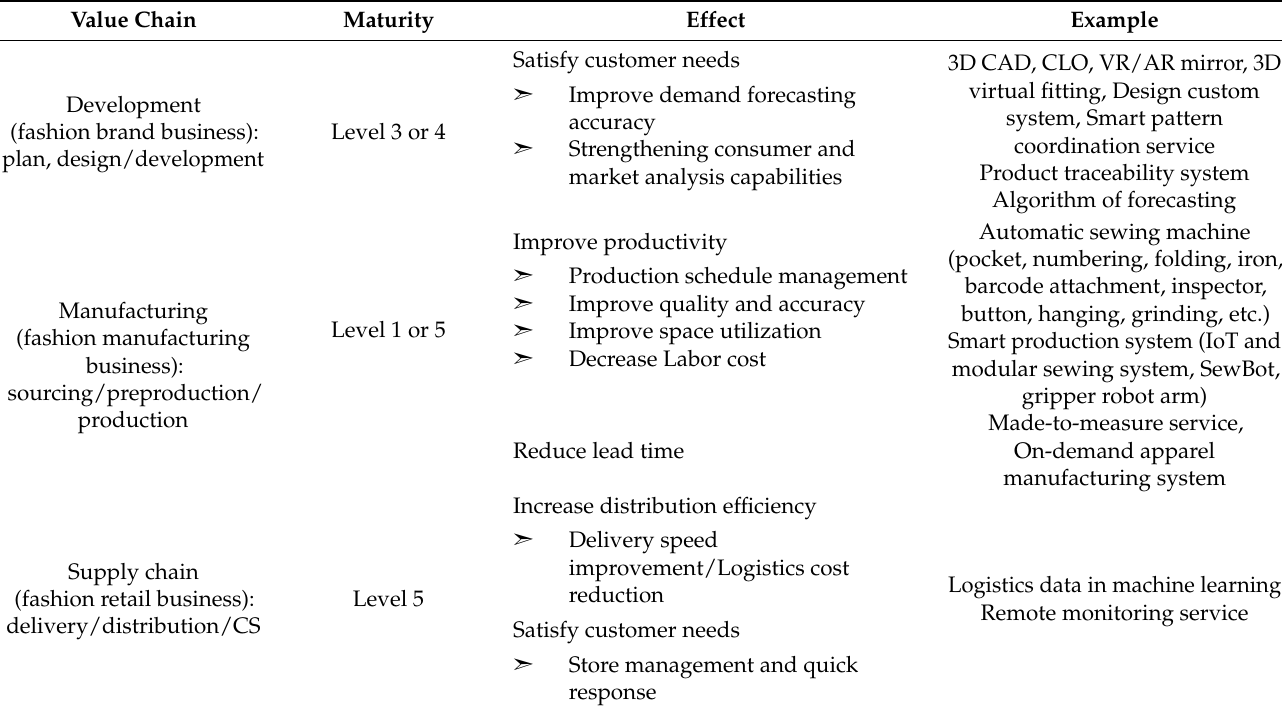
Table 1. Technology and level of maturity in current fashion smart